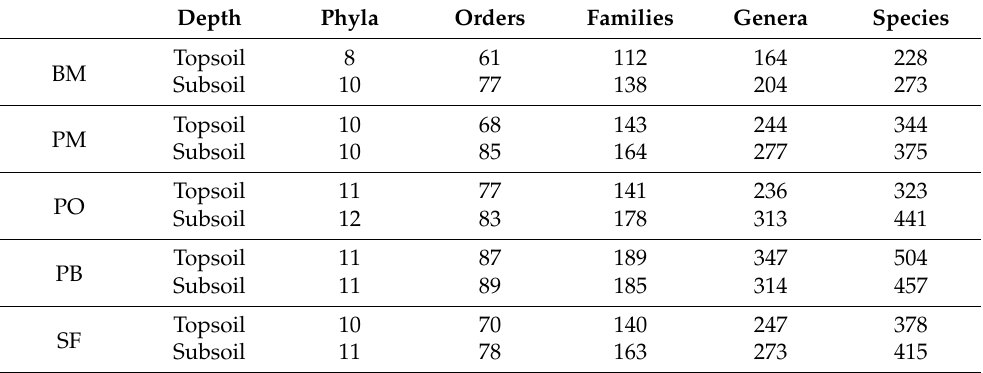
Table A1. The number of major microbial groups at the level of phyla, orders, families, genera and species obtained by high-throughput sequencing.